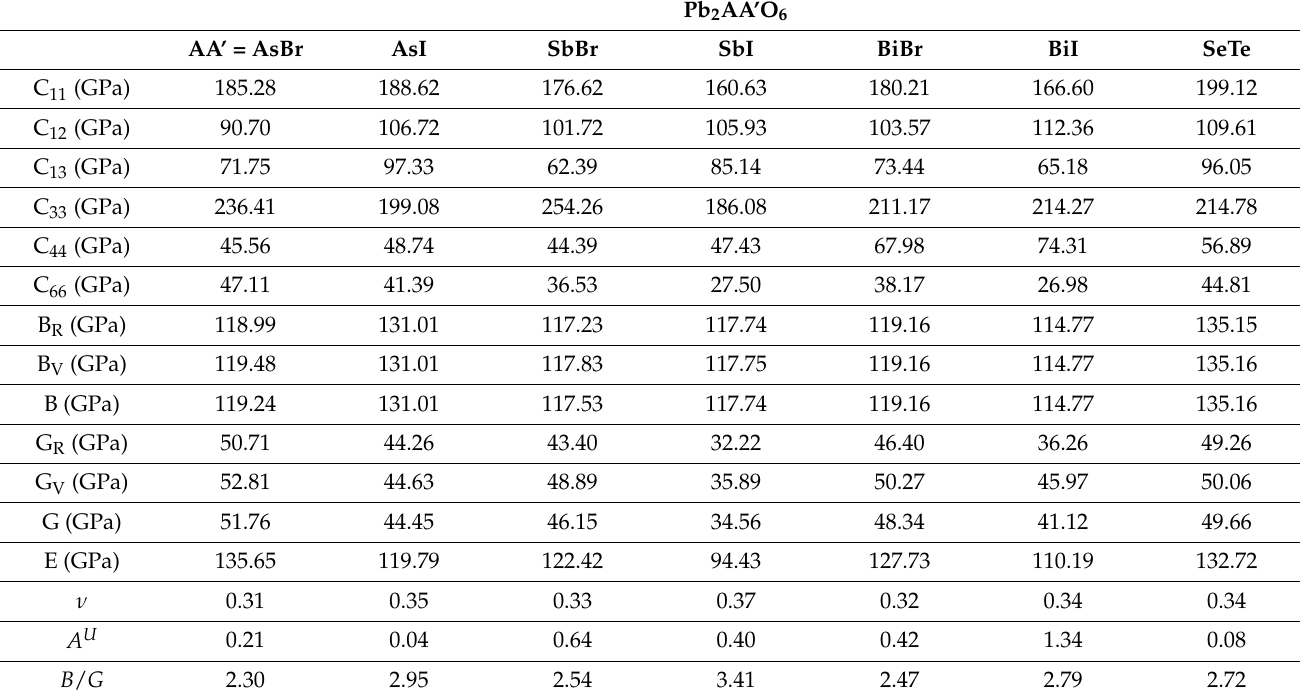
Table 2. Calculated single crystal elastic modulus C 11 , C 12 , C 13 , C 44 , C 66 , bulk modulus B ,